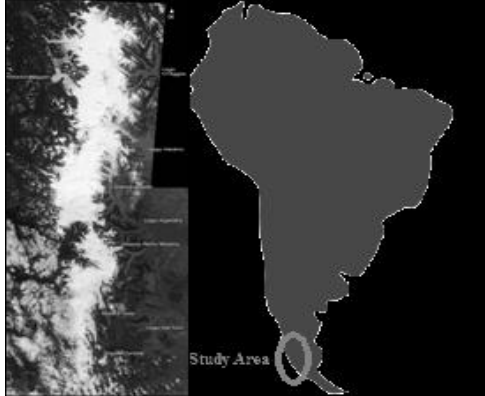
Figure 1. Study area – Mosaic of two digital photographs of Southern Patagonia